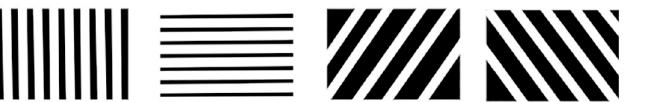
Fig 5. Examples of screen representations for the contrast grating acuity test. The recipients are asked which of four directions the lines are pointing, using progressively narrower spacing. (HK).